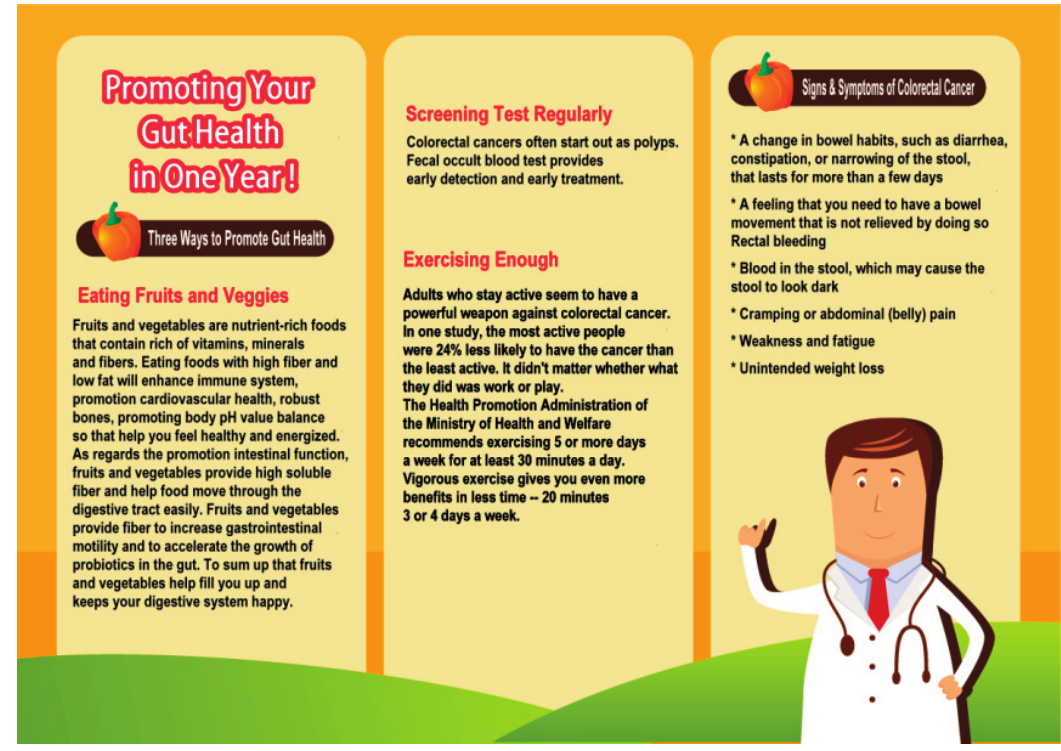
Figure 2. Promotion focus, one year and great deal of text and few graphics.